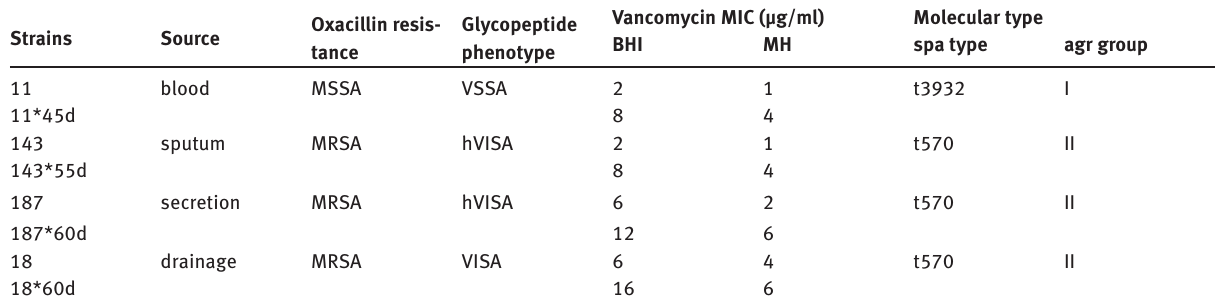
Figure 2: The electrophoretic bands of parental and derivated strains. DNA marker is Bio-Rad CHEF DNA size marker (#170-3635). Table 3: The MICvan and molecular type of four pairs of strains determined by CLSI broth microdilution method with BHI and MH medium